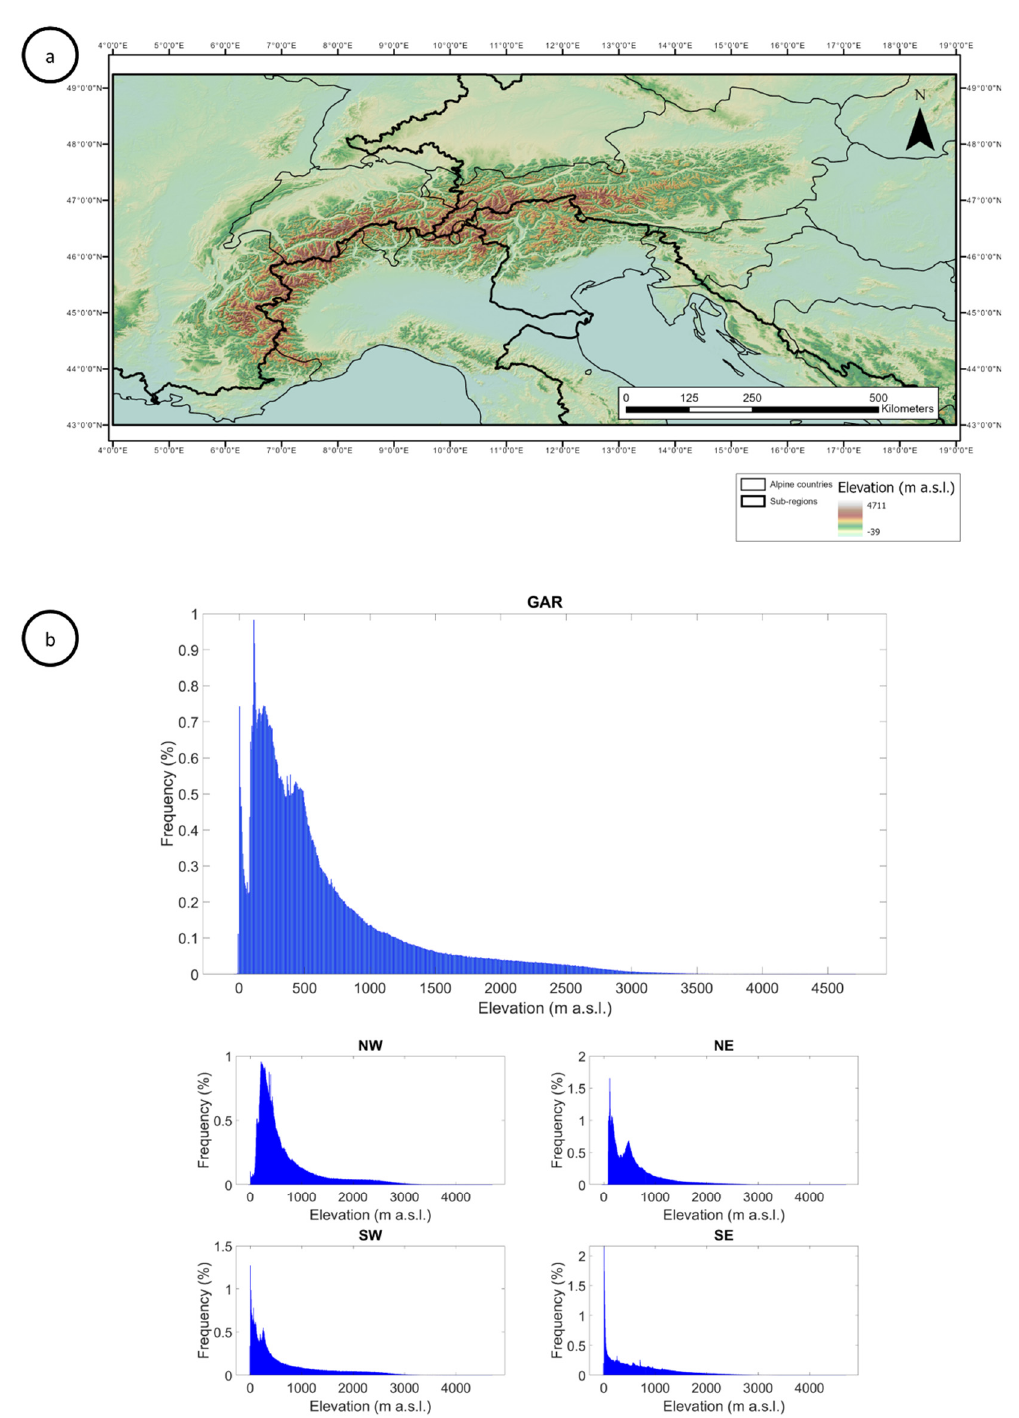
Figure 1. ( a ) the study area with the four subregions (bold black line). ( b ) frequency distributions of elevation in the Greater Alpine Region (GAR) and four subregions.